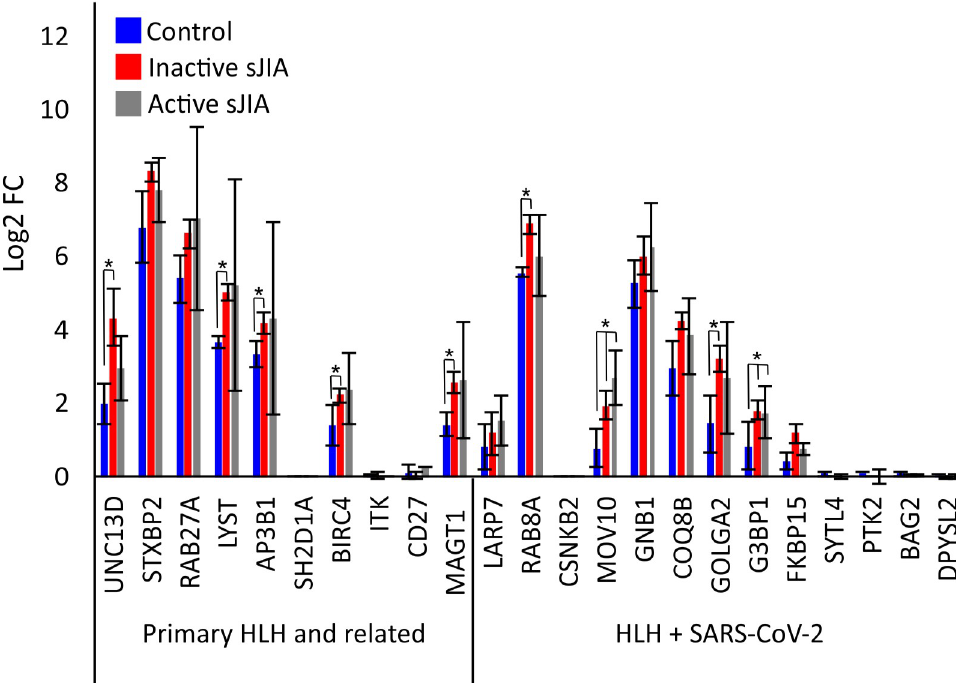
Fig 4. Expression of HLH genes in Control, inactive sJIA and active sJIA Neutrophils. Gene expression of HLH-SARS-CoV-2 and positive COVID-19 genes ( S1 Table ) in sJIA was calculated from GEO series GSE122552[54]. Data was mapped to the hg38 genome and normalized by reads per kilobase per million (RPKM). Values for HLH genes were displayed for control and sJIA patients that were either in remission (inactive sJIA) or had active symptoms (active